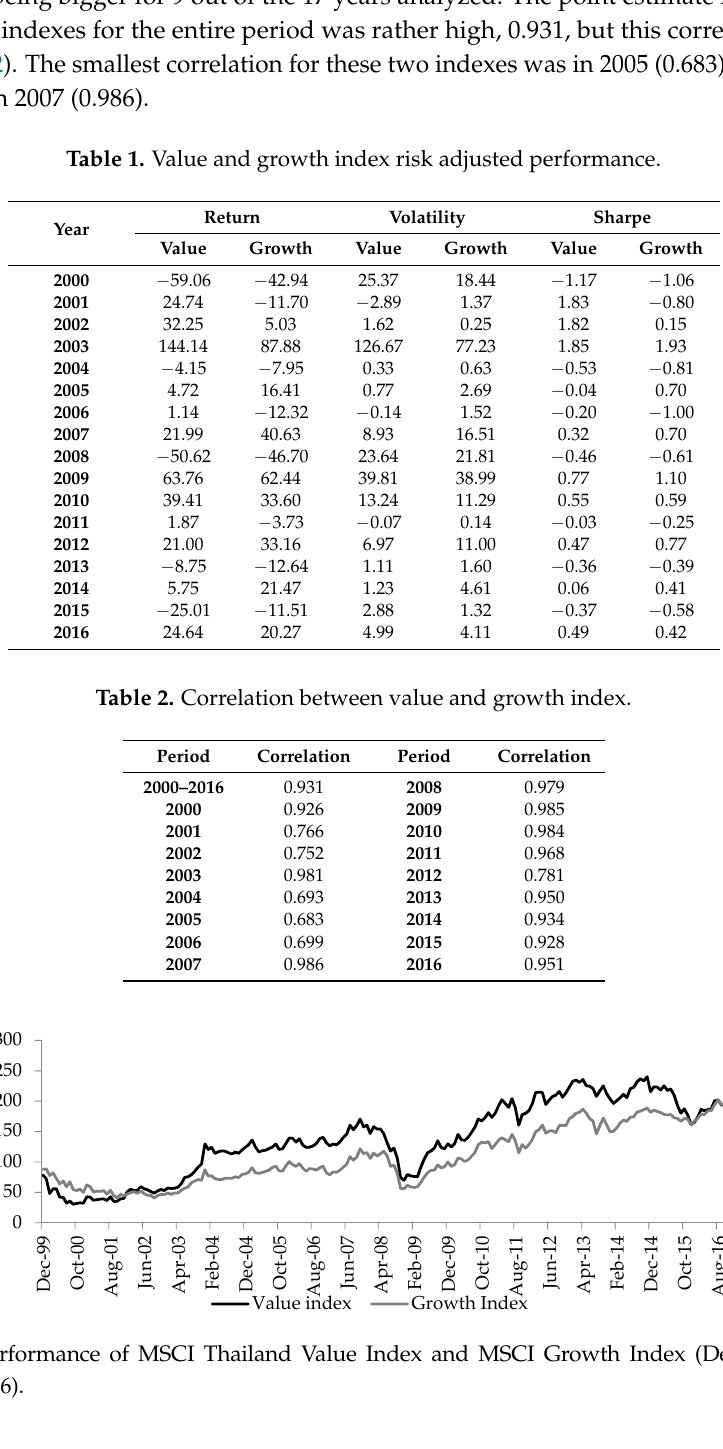
Table 3. Anderson–Darling test results ( p values) Value Index